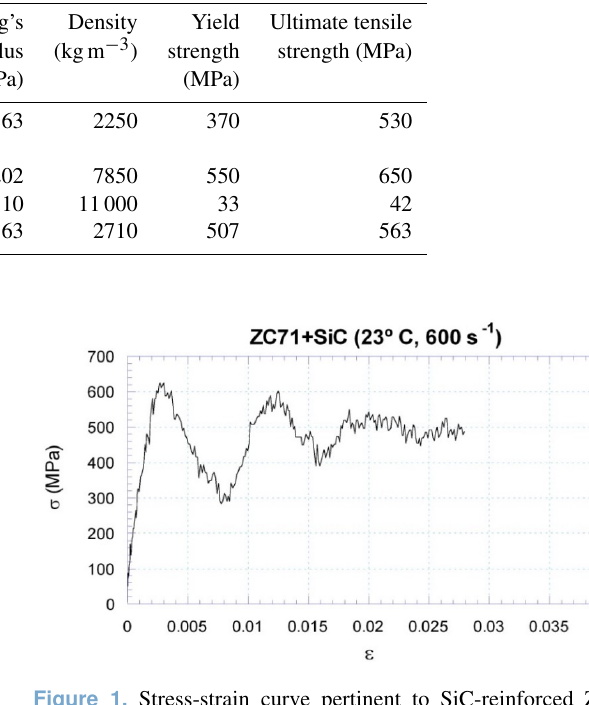
Figure 1. Stress-strain curve pertinent to SiC-reinforced ZC71 magnesium alloy at a strain rate equal to 600s − 1